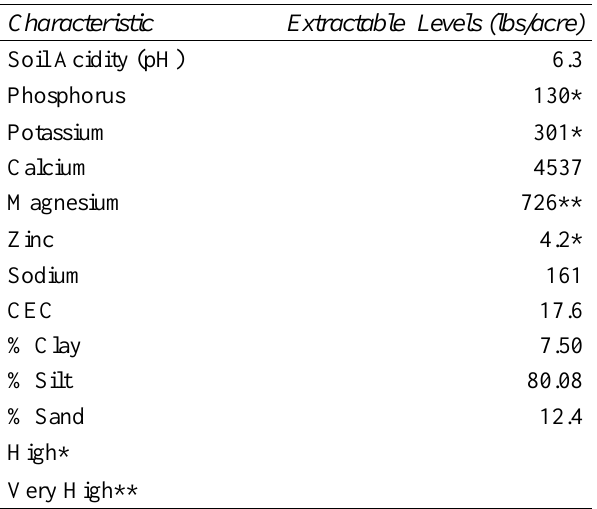
Table 1: Physical and chemical characteristics of the soil Characteristic